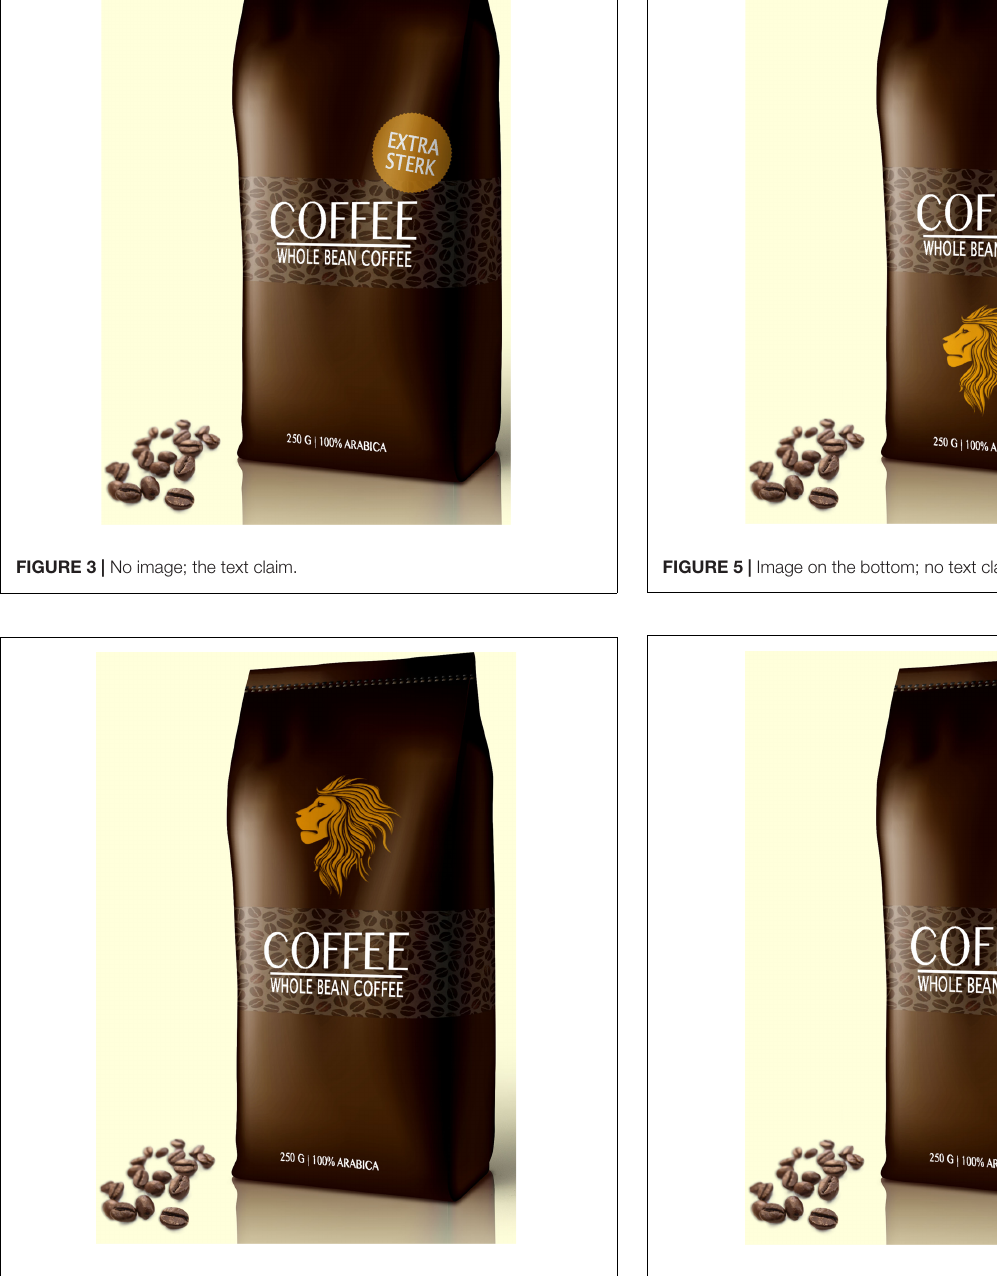
FIGURE 4 | Image on top; no text claim.